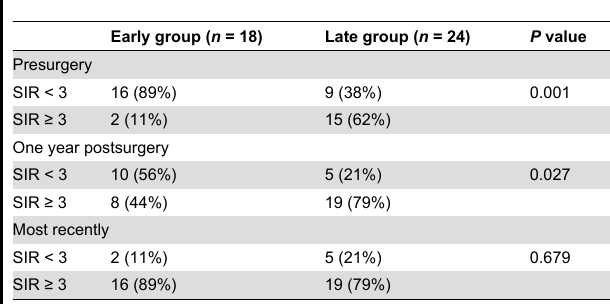
Table 5. Speech Intelligibility Rating Scale (SIR) criteria.